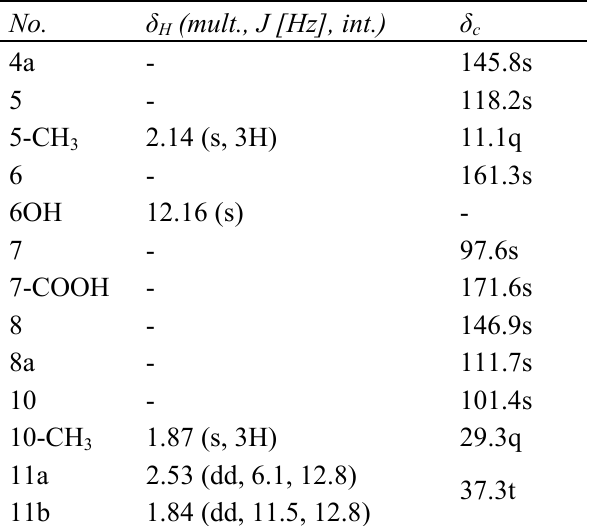
Table 3. The NMR data of compound 4 (CDCl